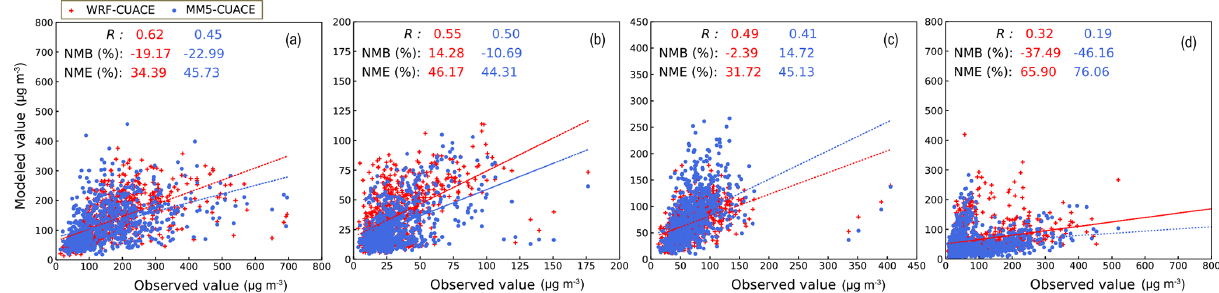
Figure 6. Scatter plots of simulated daily concentrations, with MM5/CUACE (blue) and WRF/CUACE (red), and observed daily concentra- tions of (a) PM 2 . 5 , (b) O 3 , (c) NO 2 , and (d) SO 2